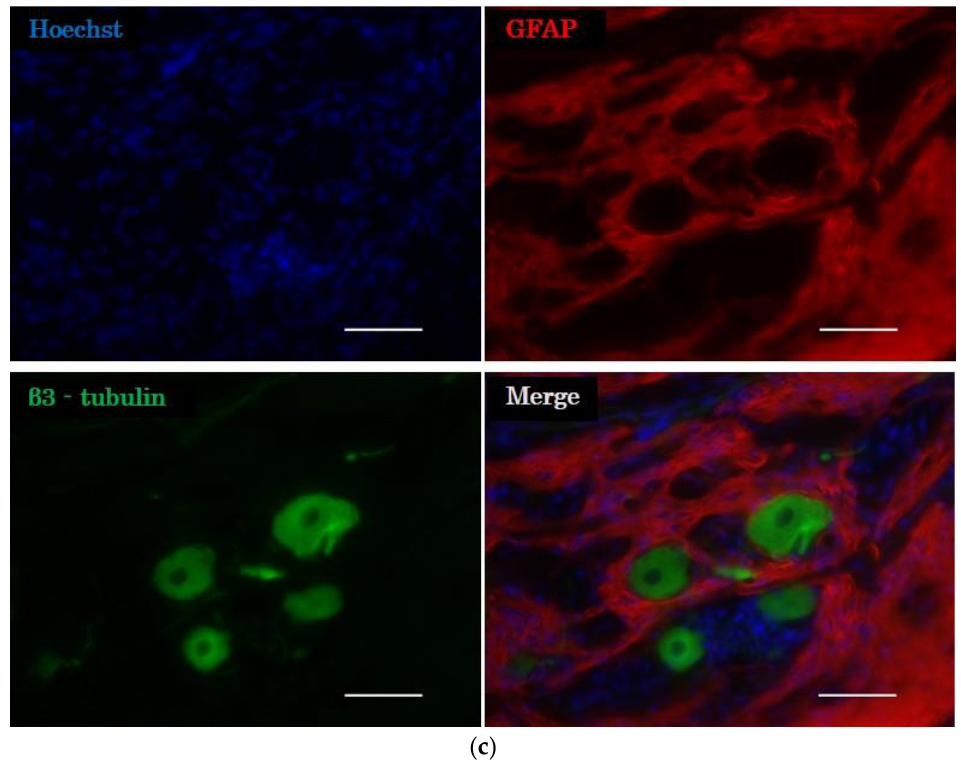
Figure 4. Evaluation of the nodule structure in the distal nerve stump. ( a ) Ectopic ganglion (arrow) was formed 12 weeks after cell transplantation in the E 45 group. ( b ) There was no enlargement of the stump of the peroneal nerve (arrow) in the surgical control group. ( c ) Microscopic image of the stump of the peroneal nerve from the E 27 group after immunohistochemical analysis. GFAP, glial fibrillary acidic protein. Scale bar = 50 µm.